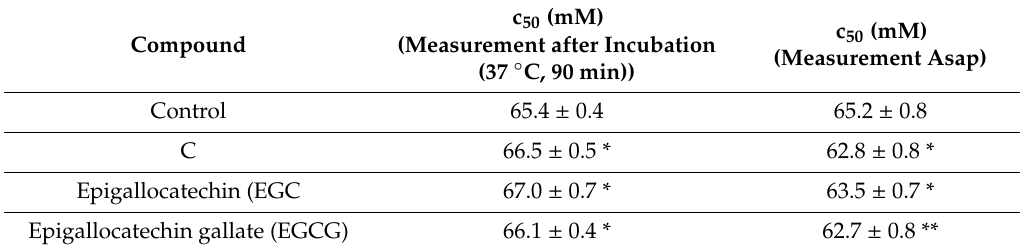
Table 1. E ff ect of selected catechins on NaCl concentration causing 50% hemolysis (c 50 ) of erythrocytes (mM). Mean ± SD, n = 3.